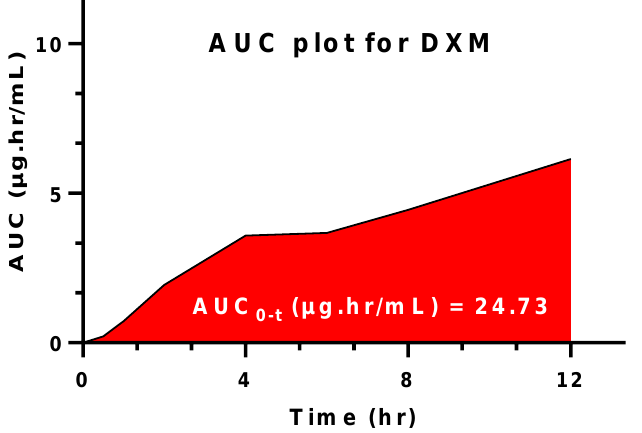
Figure 8. Area under the curve (AUC) from t 0–12 h for Q7. Table 3. Salivary pharmacokinetic estimation of the optimized formulation for local release. Parameters